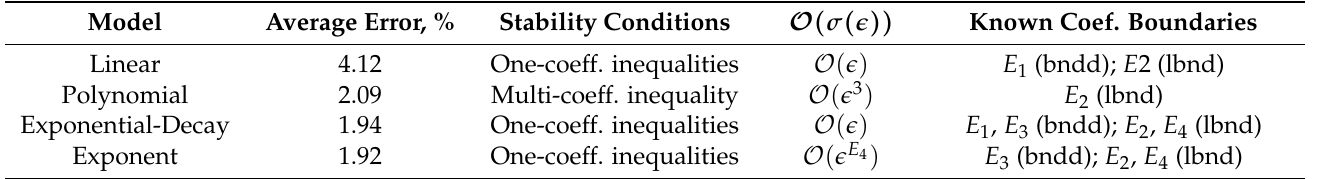
Figure 11. Obtained stress–strain relationship for zero pressure, P = 0, for FAM1. A high-level comparison of the stress models is shown in Table 5. The average error was calculated from the average errors for the two FAMs shown in Table 3. Expanding the linear model with non-linear terms led to a decrease of the average error by 50%. Among the three non-linear models, the exponent model had the smallest average error. Table 5. Comparison of constitutive models. Models were compared with: their average error, if there was a simple expression for each coefficient, or a multi-coefficient expression was needed to satisfy the material stability criterion, growth rate in Big O notation, and for which coefficients boundaries are known. Bndd stands for bounded, and lbnd stands for lower